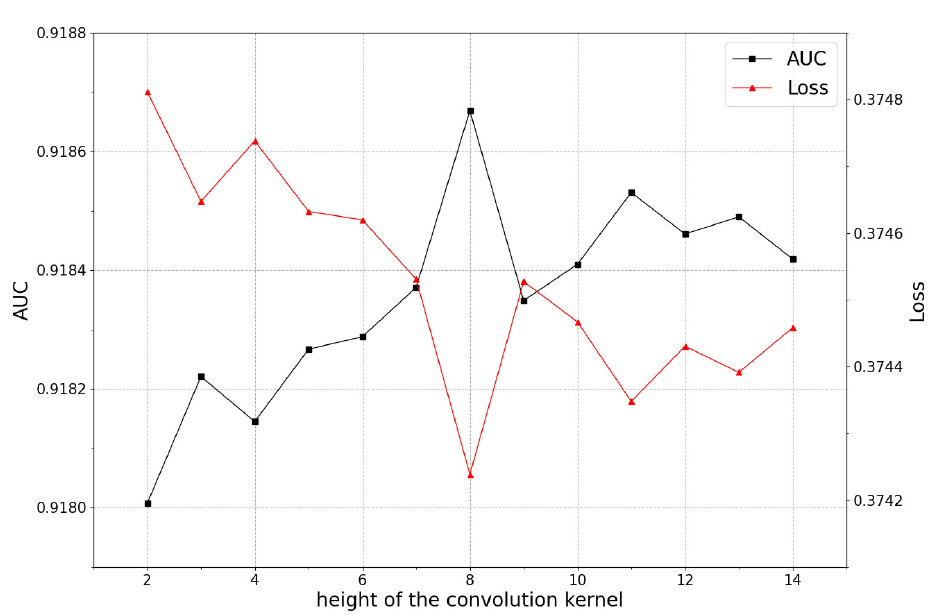
Figure 6. The impact of the height of convolution kernel on model performance.